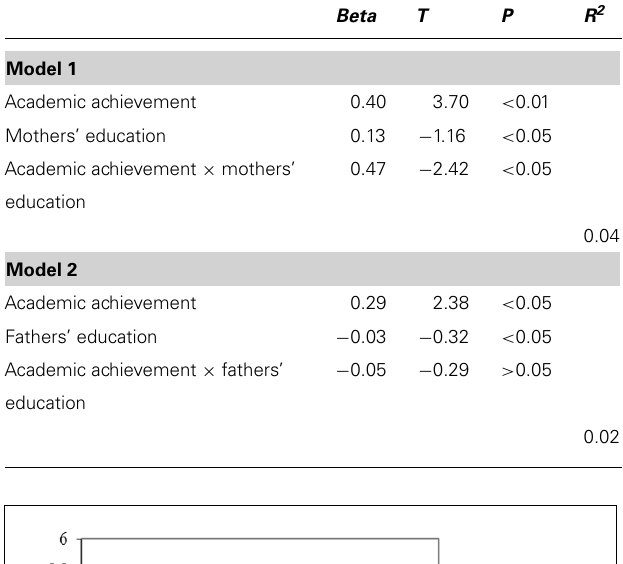
Table 2 | Intercorrelations of students’ grades and life satisfaction (LS) measures. Descriptives